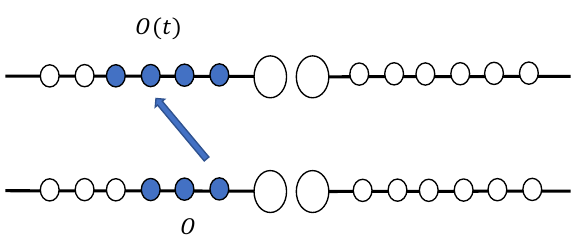
Figure 12 . Processes of forming a void in B 1 which result in final operators contained in B 1